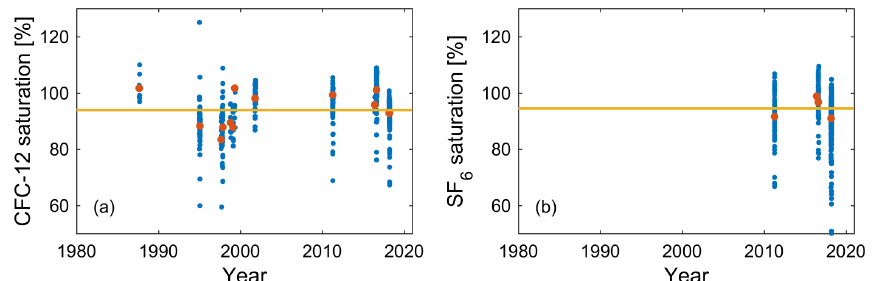
Figure 8. Historical surface saturations in winter mixed layers (blue solid circles) for (a) CFC-12 from 12 cruises in 1987–2018 and (b) SF 6 from 4 cruises in the Mediterranean Sea (Li and Tanhua, 2020). Red solid circles denote the means of seawater saturation for each cruise, and the yellow lines (94%) are the means of seawater saturation from all